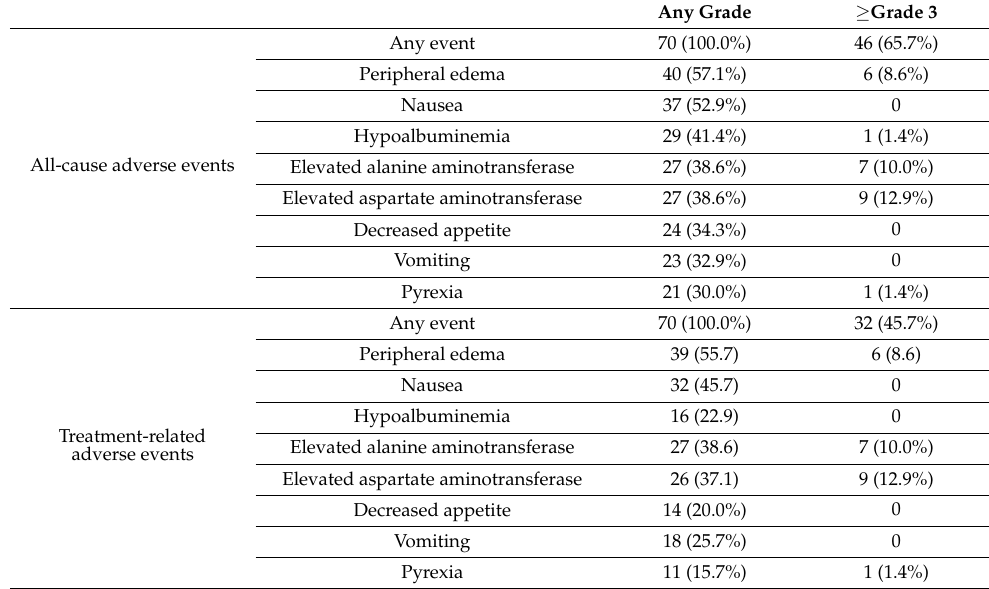
Table 4. Adverse events (>30%) in the full analysis set of phase II trials conducted in China ( n = 70)